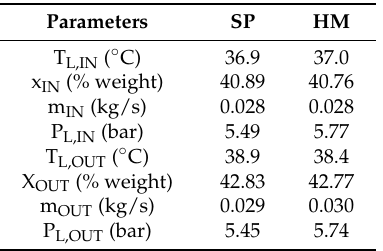
Table 4. Experimental results with